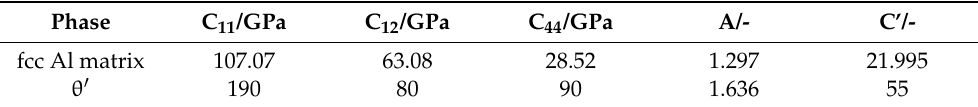
Table 3. Elastic constants of the matrix and precipitate